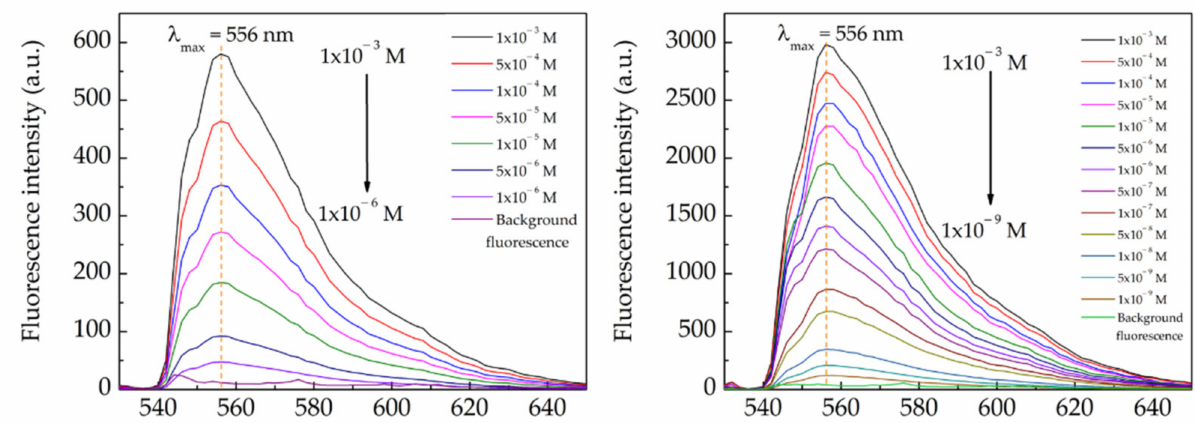
Figure 11. Fluorescence spectra of R6G solution measured on: ( a ) silicon substrate and ( b ) MEF